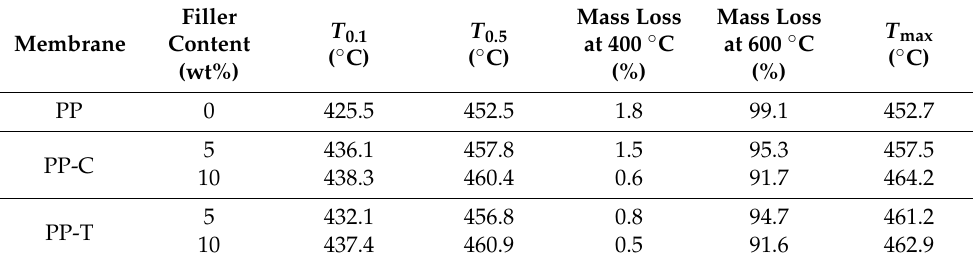
Figure 6. ( a ) Thermogravimetric analysis (TGA) and ( b ) Derivative thermogravimetric (DTG) curves showing the thermal decomposition of the membranes with outer layers consisting of: (1) neat PP, (2) polypropylene filled with 5 wt% CaCO 3 (PP-5C), (3) polypropylene filled with 10 wt% CaCO 3 (PP-10C), (4) polypropylene filled with 5 wt% talc (PP-5T), (5) polypropylene filled with 10 wt% talc (PP-10T). Table 3. Thermogravimetric analysis results. Membrane code refers to the outer PP-based